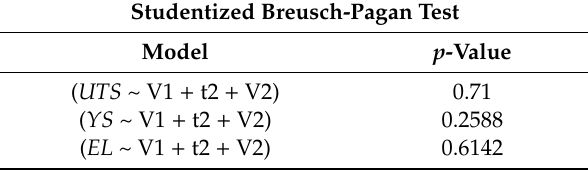
Table 6. Breusch-Pagan test for verification of the homogeneity of the variance of the residuals for each response